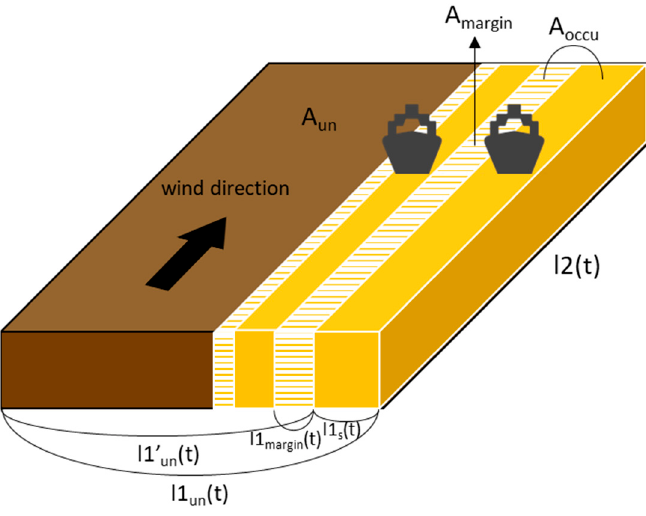
Figure 2. Definitions of spaces used in the SNR model.